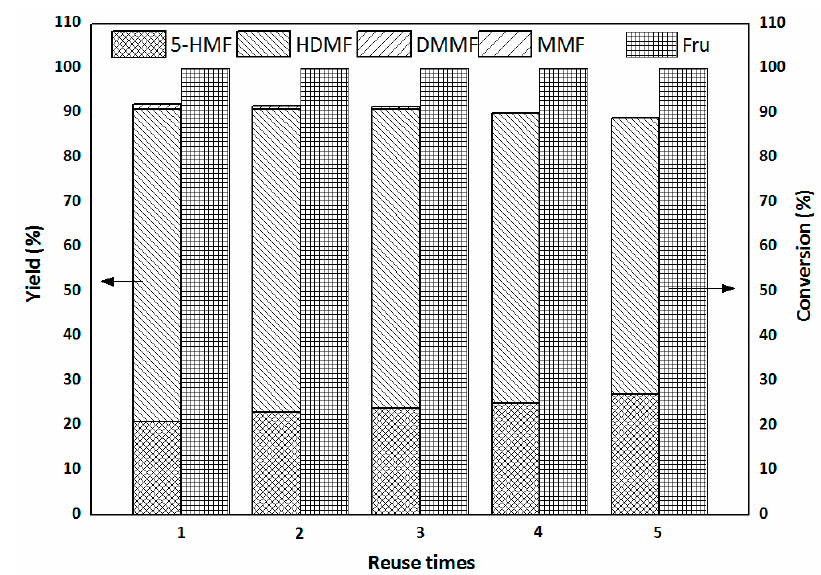
Figure 8. Results of the reuse study. Reaction conditions: 1.37 mmol fructose in 4.0 mL DMSO at 150 °C with 50 mg SiO 2 ‐ HNO 3 ; after 2 h, 9.3 mL methanol was added, and the reaction time was extended to 3 h at 100 °C.